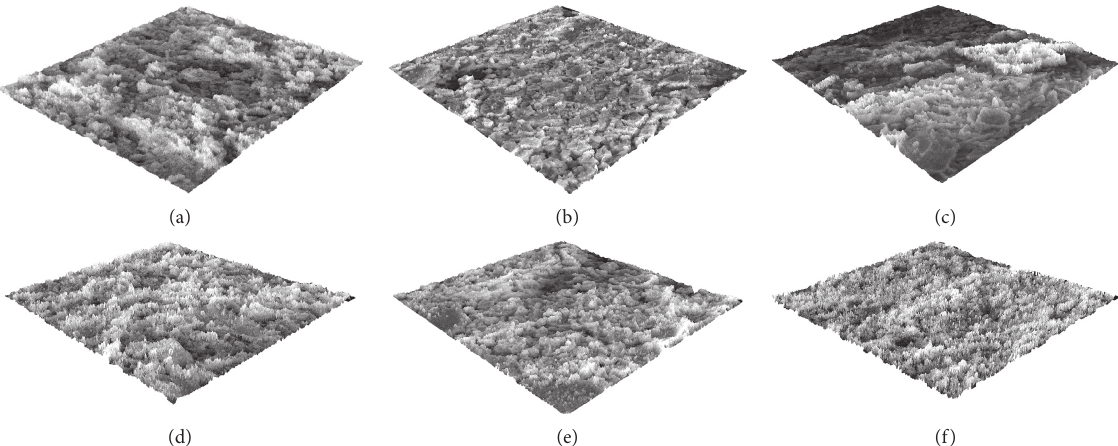
Figure 9: 3D visualizations of the soil surfaces before and after the electro-osmosis process. (a) Untreated soil. (b) T1 (no solute). (c) T2 (K + ).